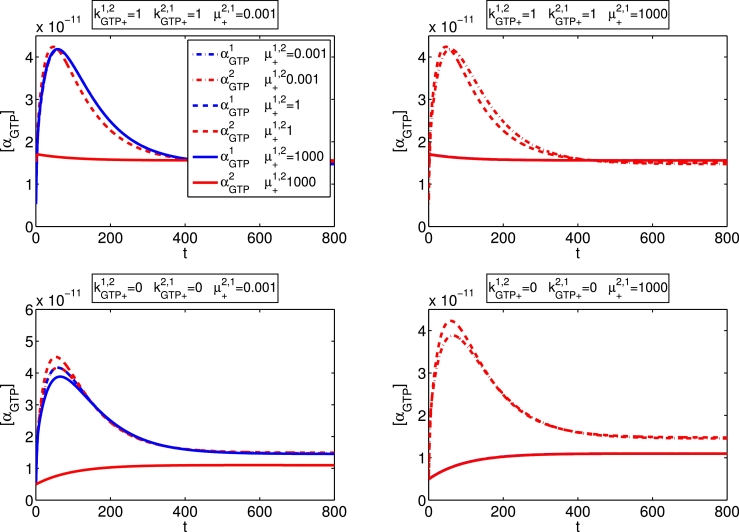
Time courses for varying agonist accessibility of receptor cross states. Here, [L]=10−5 M.